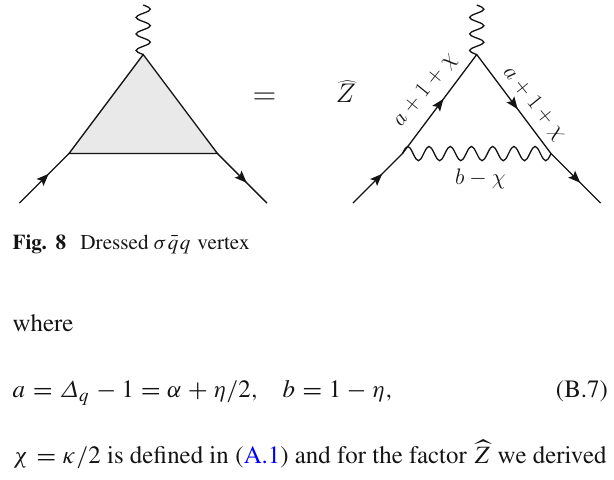
Fig. 8 Dressed σ ¯ qq